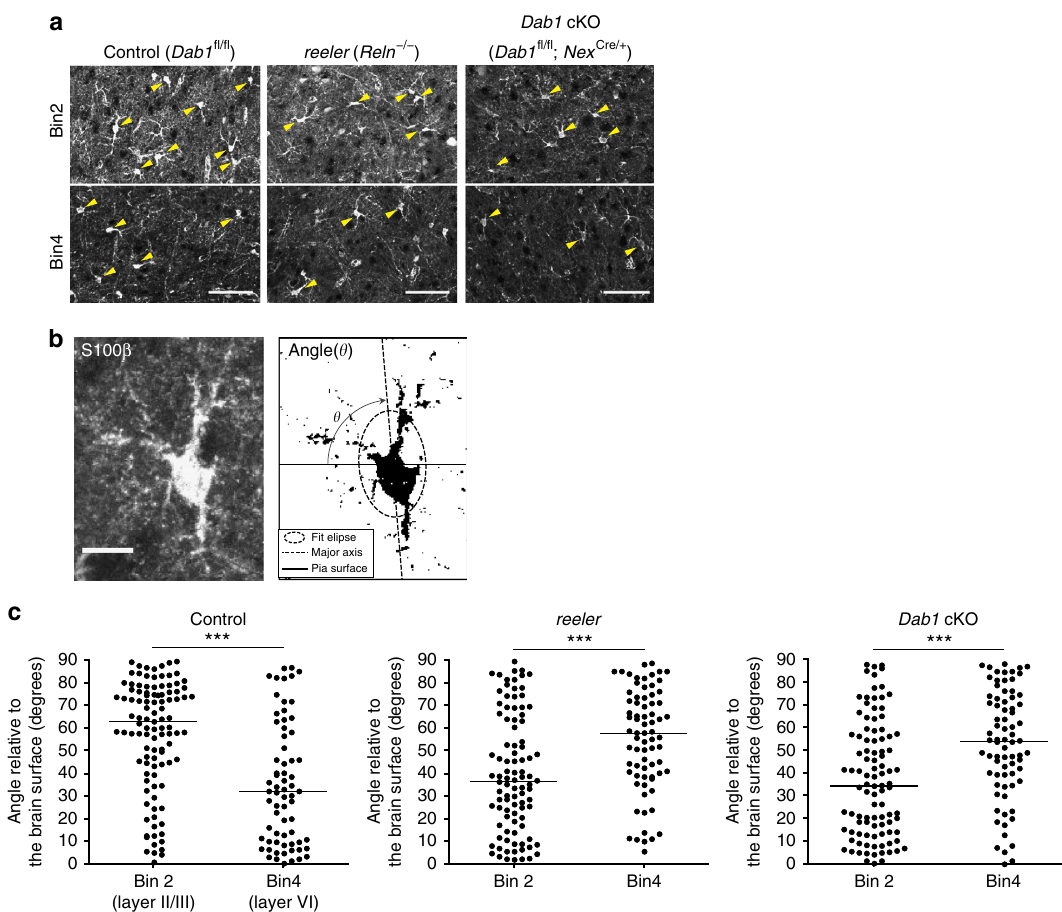
Fig. 7 Disruption of layer-speci fi c astrocyte orientation in reeler and Dab1 cKO mice. a Immuno fl uorescence staining for S100 β in bin2 (layer II/III) and bin4 (layer VI) of coronal brain sections from control ( Dab1 fl / fl ), Dab1 cKO ( Dab1 fl / fl ; Nex Cre/ + ), and reeler ( Reln − / − ) mice at P60 – P70. Arrowheads indicate S100 β -positive astrocytes. Scale bars, 50 µ m. b Schematic for measurement of astrocyte orientation relative to the brain surface based on S100 β immunostaining. Scale bar, 10 µ m. c Quanti fi cation of the orientation angle of astrocytes (S100 β -positive, Sox10-negative cells) in bin2 and bin4 of control, Dab1 cKO, and reeler mice ( n = 3 mice) at P60 – P70. Horizontal bars indicate median values. Control, n = 106 and 68 cells; Dab1 cKO, n = 100 and 76 cells; reeler , n = 96 and 74 cells for bin2 and bin4, respectively. *** P < 0.001 (Welch ’ s t